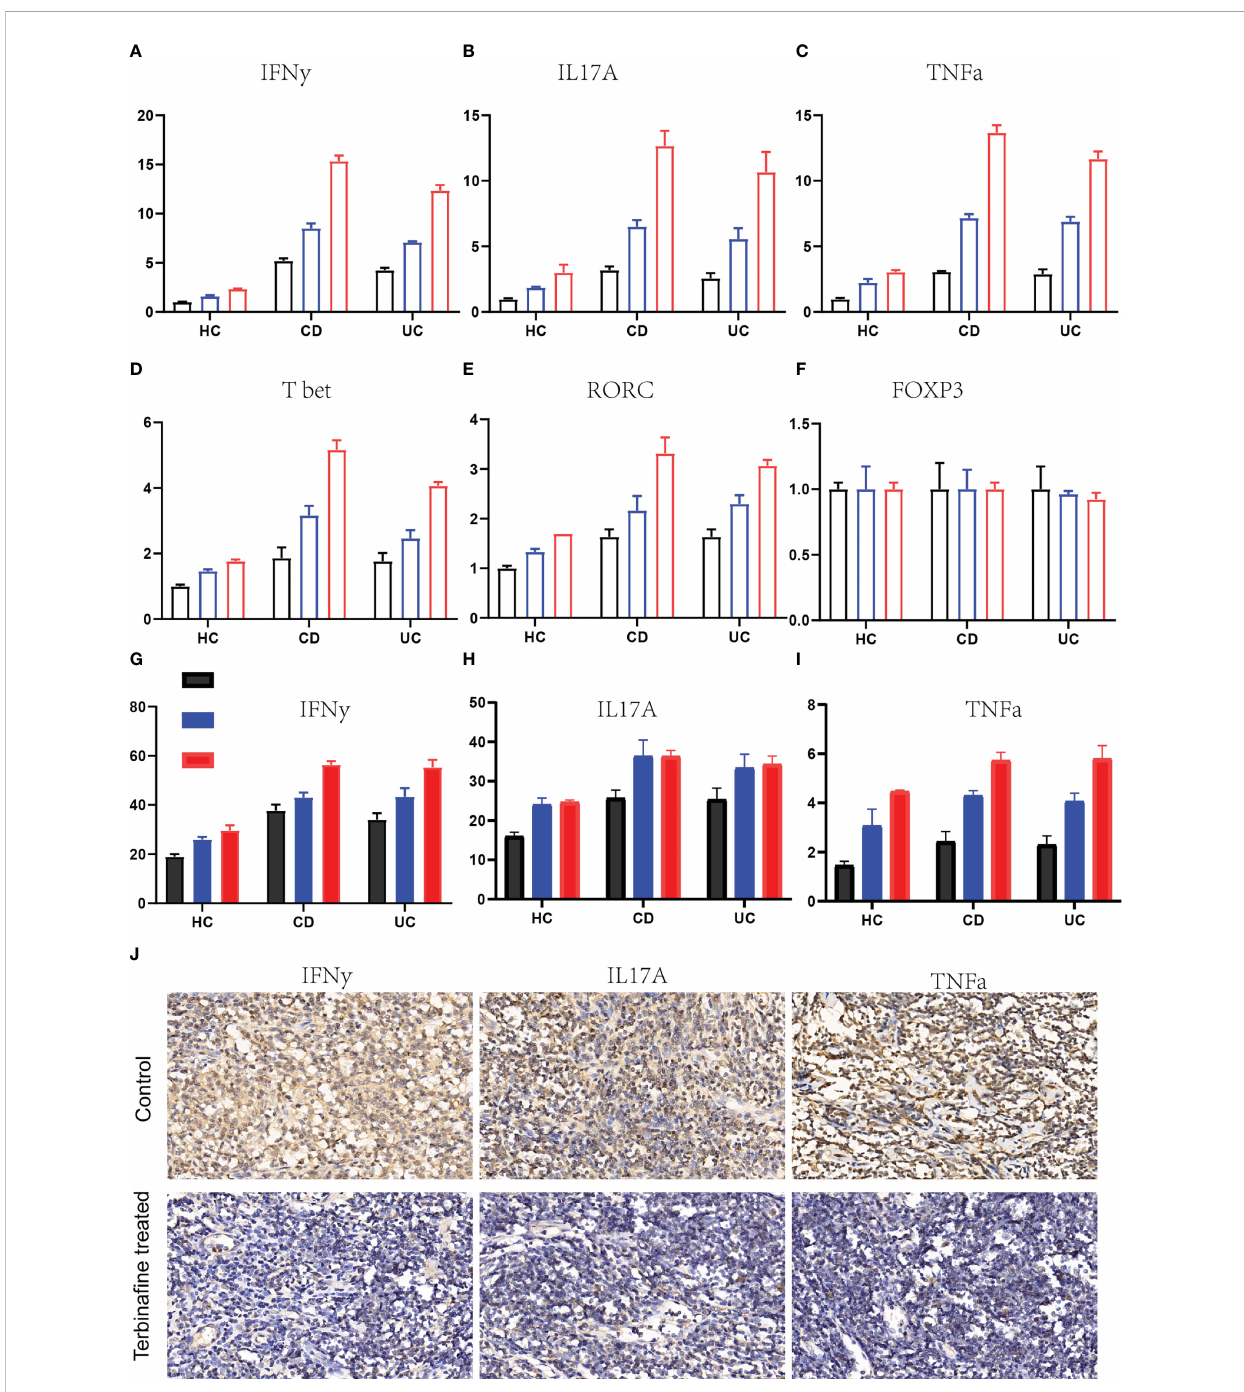
FIGURE 3 Fungi infection facilities the production of in fl ammation cytokines in CD4+ T cells. (A-C) . The relative IFN g (A) , IL17A (B) and TNF a , n = 5. (C) genes expression in the CD4+ T cells drived from HC, CD and UC patients that infected with different dose of Candida albicans , n = 5. (D – F) . The expression changes of transcription factors of T-bet-Th1, n = 5. (D) , RORC-Th17 (E) and Foxp3-Treg (F) under fungal infection. (G – I) . The protein expression of IFN g (G) , IL17A (H) and TNF a (I) in ther supernatant of CD4+ T cells culture medium detected by enzyme-linked immunosorbent assay, n = 5. (J) . The IHC staining of IFN g , IL17A and TNF a in the colon specimens that received the terbina fi ne or control